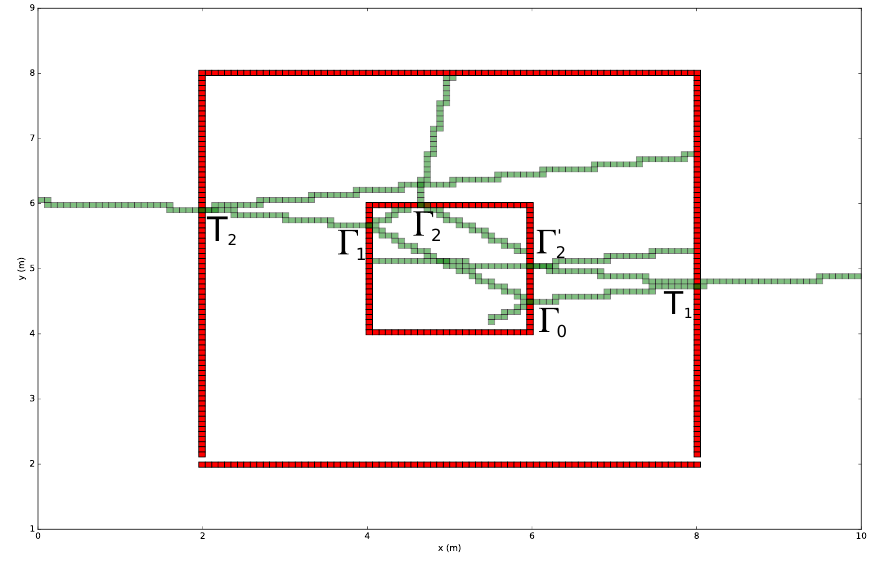
Figure 9. Example of a ray